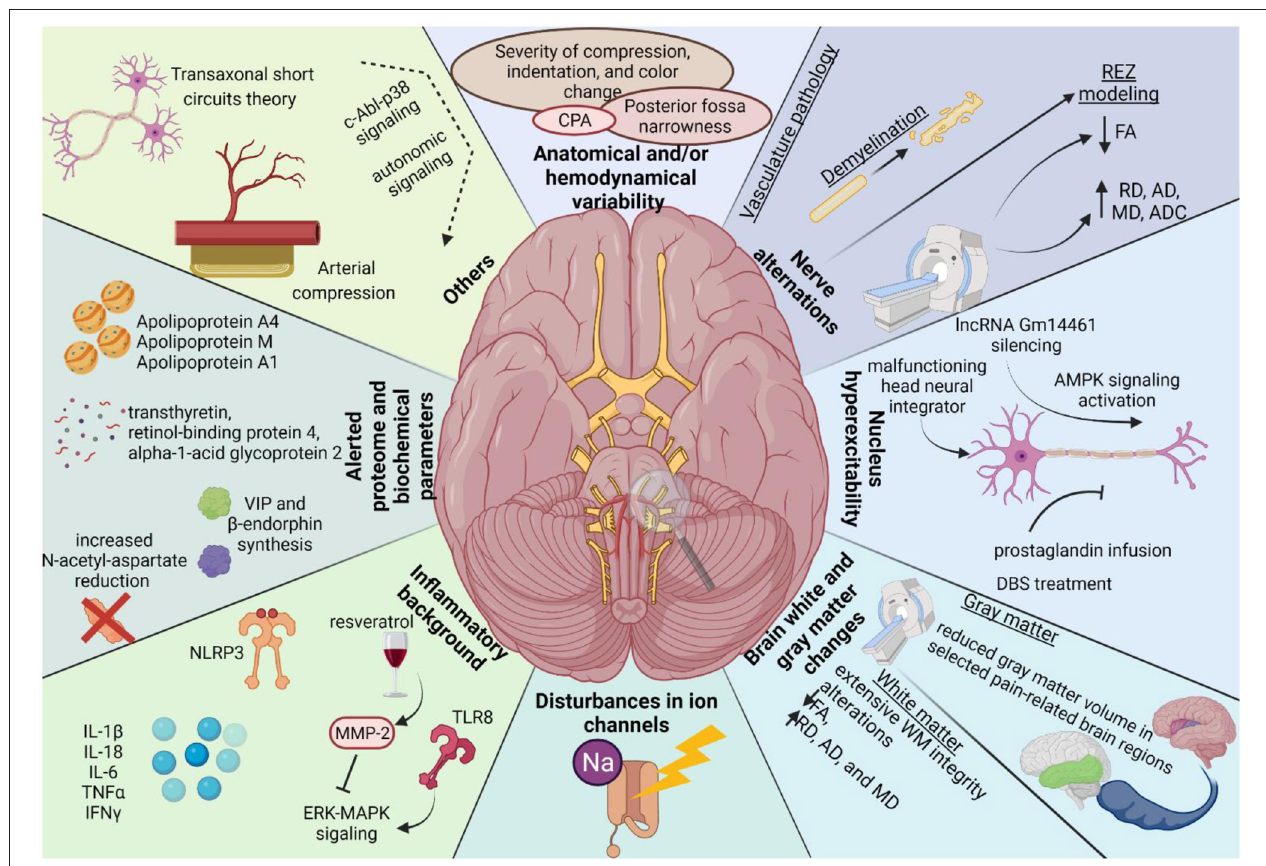
FIGURE 2 | The graphical summary of the underlying pathogenesis of neurovascular compression syndromes based on performed systematic review. Legend as follow: AD, axial diffusivity; ADC, apparent diffusion coefficient; AMPK, adenosine monophosphate-activated protein kinase; CPA, cerebellopontine angle; FA, fractional anisotropy; MD, mean diffusivity; MMP-2, metalloproteinase-2; NLRP3, nucleotide-binding domain (NOD)-like receptor protein 3; lncRNA, Long non-coding RNA; RD, radial diffusivity; REZ, root entry/exit zone; WM, white